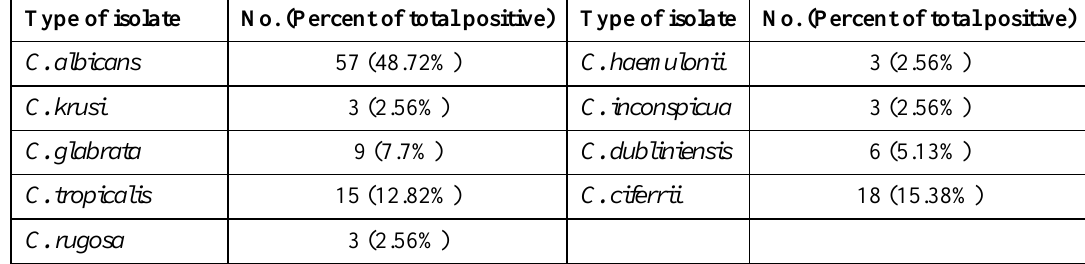
Table 2. Types of 117 (46.8%) Candida isolates as identified by Vitek 2 automated yeast identification system (YST